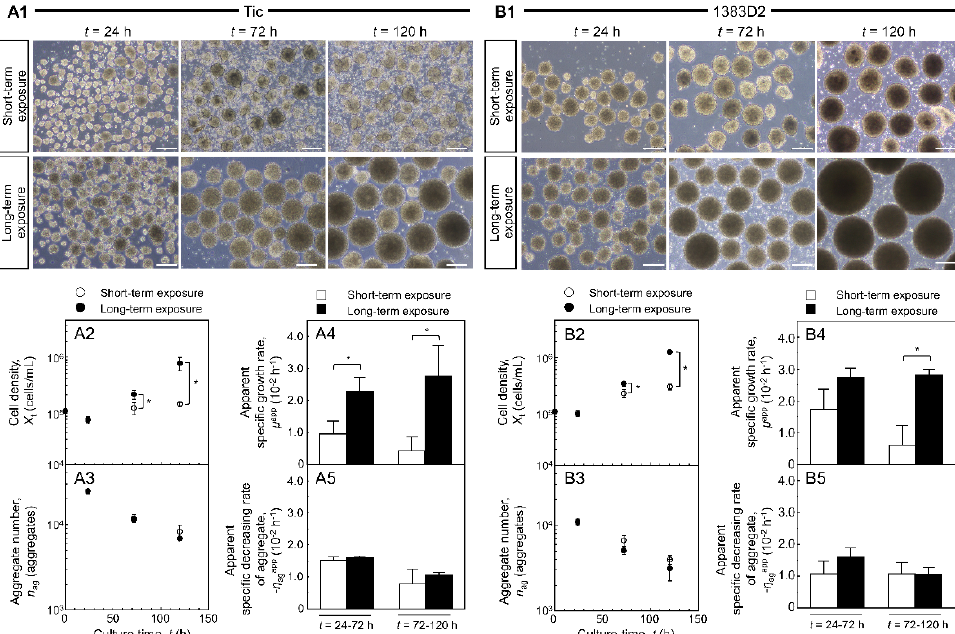
Figure 1. The effect of Rho–associated protein kinase (ROCK) inhibitor on aggregate morphology, cell density, and aggregate number of two different hiPSC lines (( A ), Tic; ( B ), 1383D2) in suspension culture with short- and long-term exposure to ROCK inhibitor. ( A1 , B1 ) Aggregate morphology. Scale bars, 200 μ m. ( A2 – 5 , B2 – 5 ) Cell density, aggregate number, apparent specific growth rate, and apparent specific decreasing rate of aggregates. Statistical significance was analyzed by two-tailed Student’s t -tests; * p < 0.05 ( n = 3 per culture). Error bars represent standard deviation. Open circle and bars, short-term exposure to ROCK inhibitor; Closed circle and bars, long-term exposure of ROCK